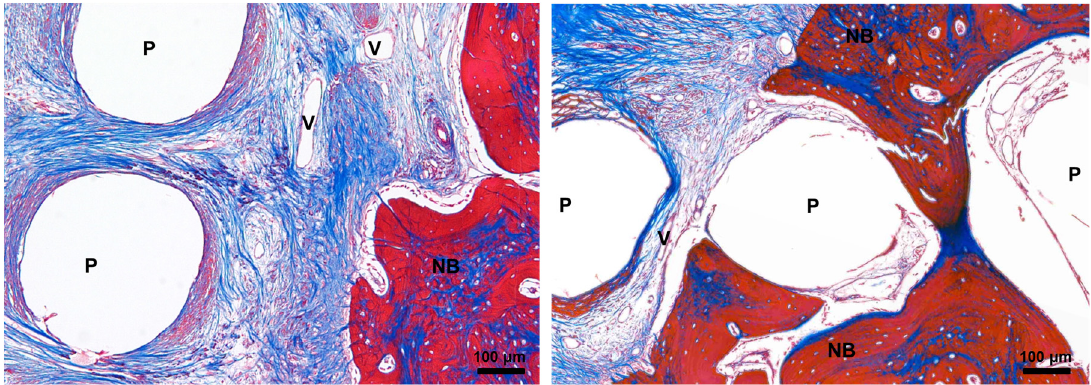
Figure 6. Magnification (×40) of newly formed bone and PCL scaffolds. The specimens were decalcified and stained with Masson’s trichrome. NB, new bone; P, PCL scaffolds; V, vessel.